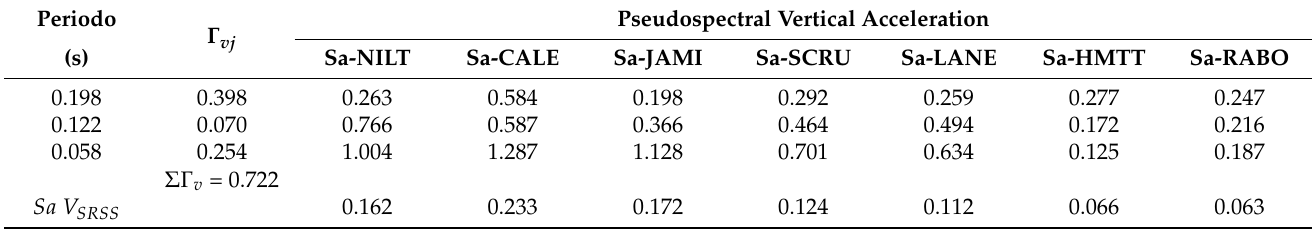
Table 8. Accelerations due to vertical earthquake in the 10-story building. Table 6. Resultant accelerations of the horizontal plus vertical components (6-story building).